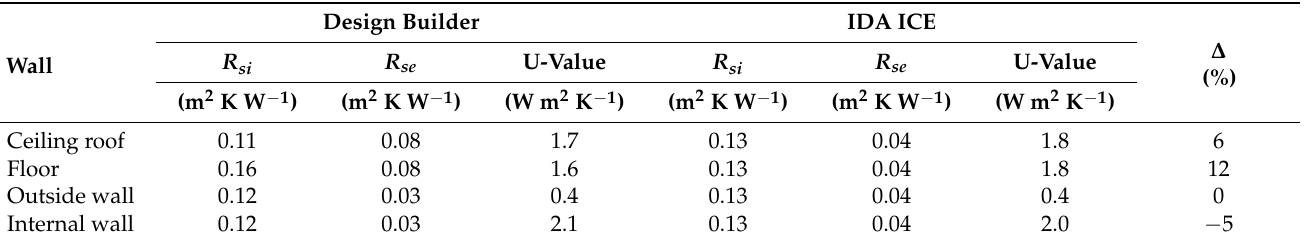
Table 1. Comparison between U-values calculated by Design Builder and IDA ICE in static regime according to reference Standard values of resistance for each software. R si : internal resistance; R se : external resistance, ∆ : difference in U-values.